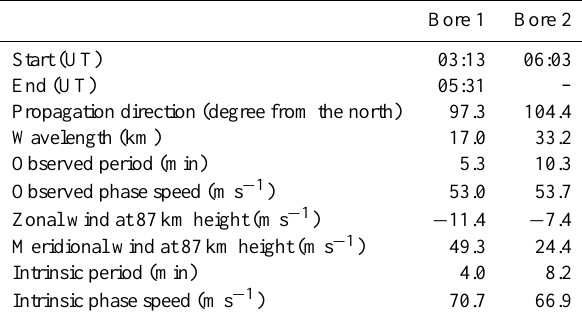
Table 1. Horizontal parameters of the twin bores derived from the images and meteor radar measurements.